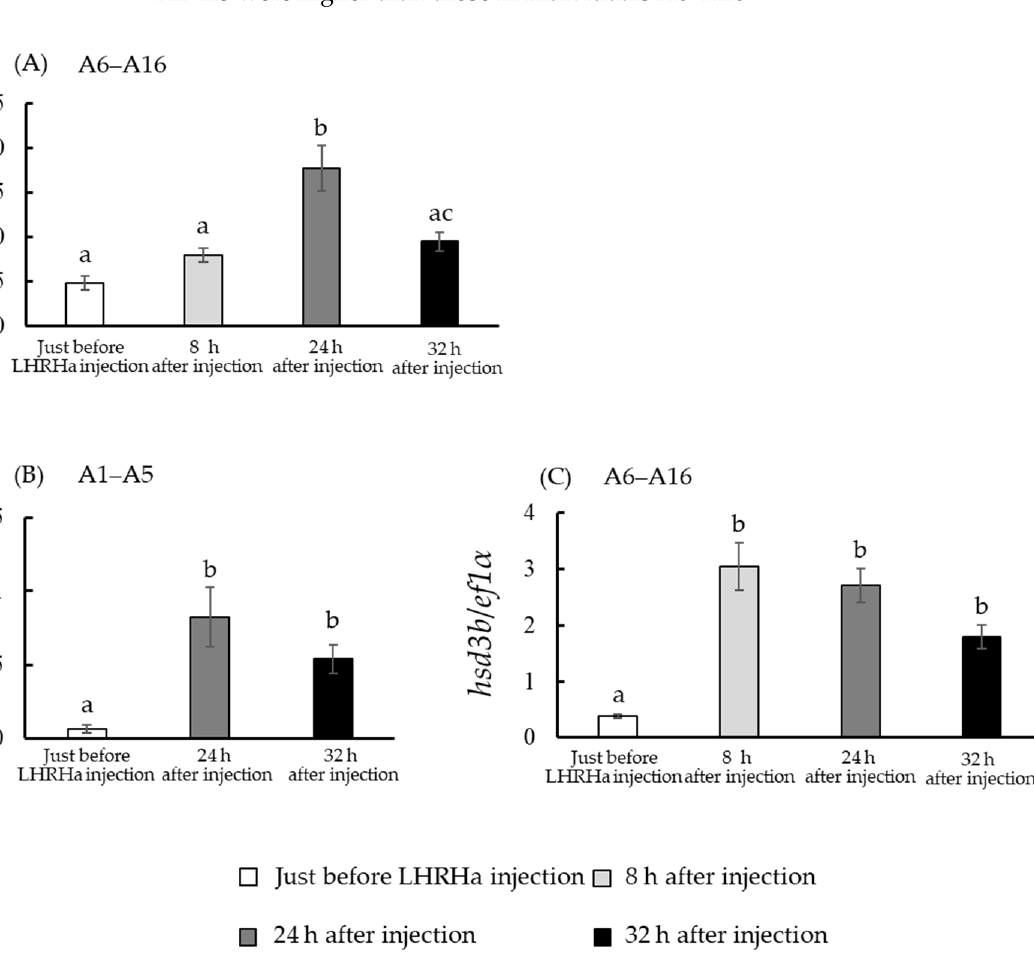
Figure 4. Serum DHP levels and hsd3b mRNA levels of ovarian follicles. Levels in individuals (A1– A16) just before (white column), and 8 h (light gray column), 24 h (dark gray column), and 32 h (black column) after injection. Some individuals (A1–A5) did not reach ovulation, while other individuals (A6–A16) did. Panels ( A , C ) show the average serum DHP concentrations and hsd3b mRNA levels between individuals A5–A16. Panel ( B ) shows the hsd3b mRNA levels between individuals A1–A5. Different letters represent a significant difference among groups ( p < 0.05).